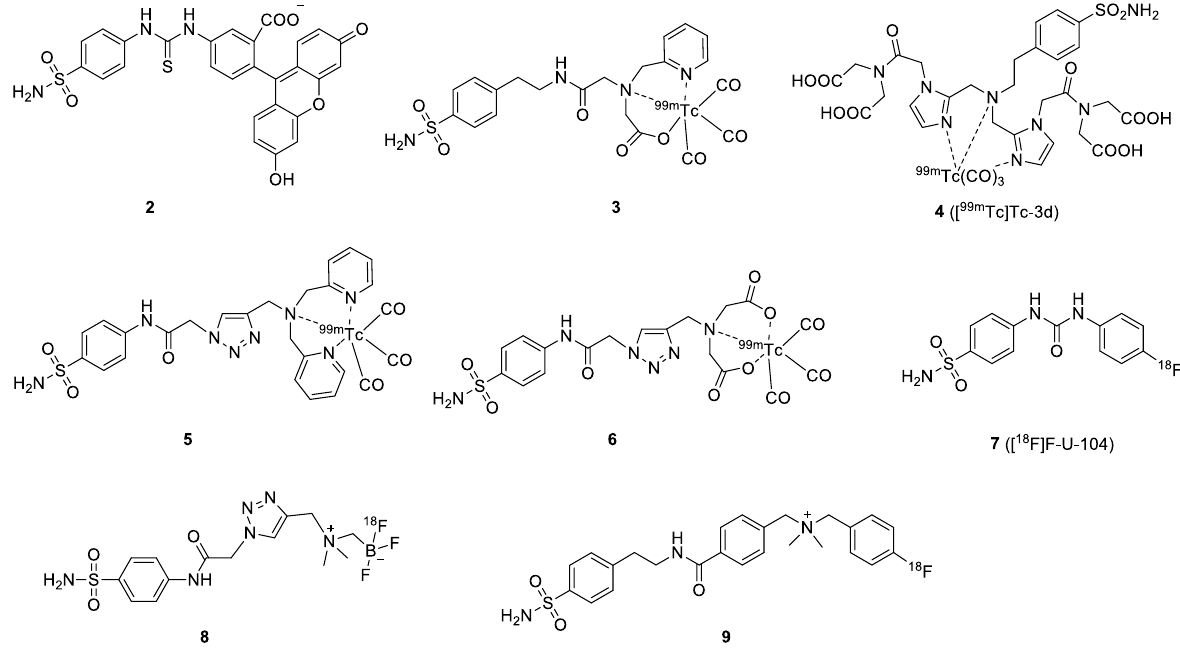
Figure 3. Chemical structures of BSA-based CAIX probes.